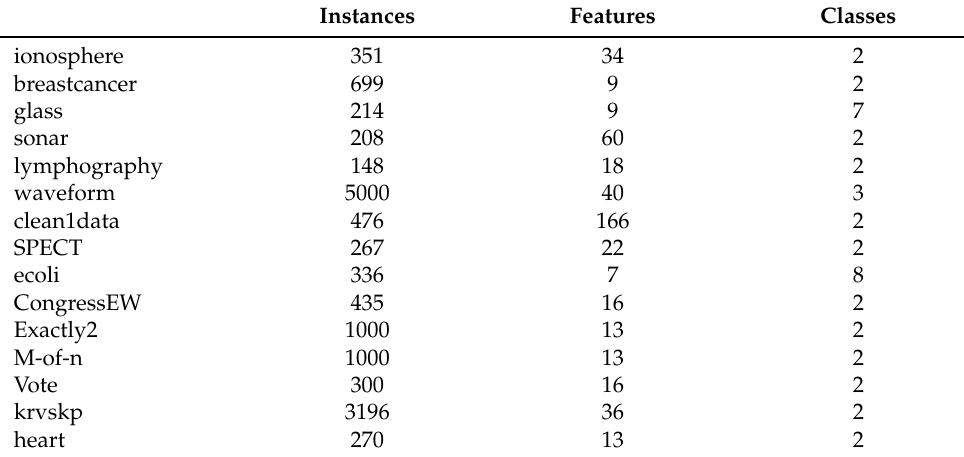
Table 6. Description of the UCI